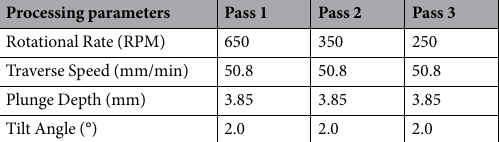
Table 1. Processing parameters selected for